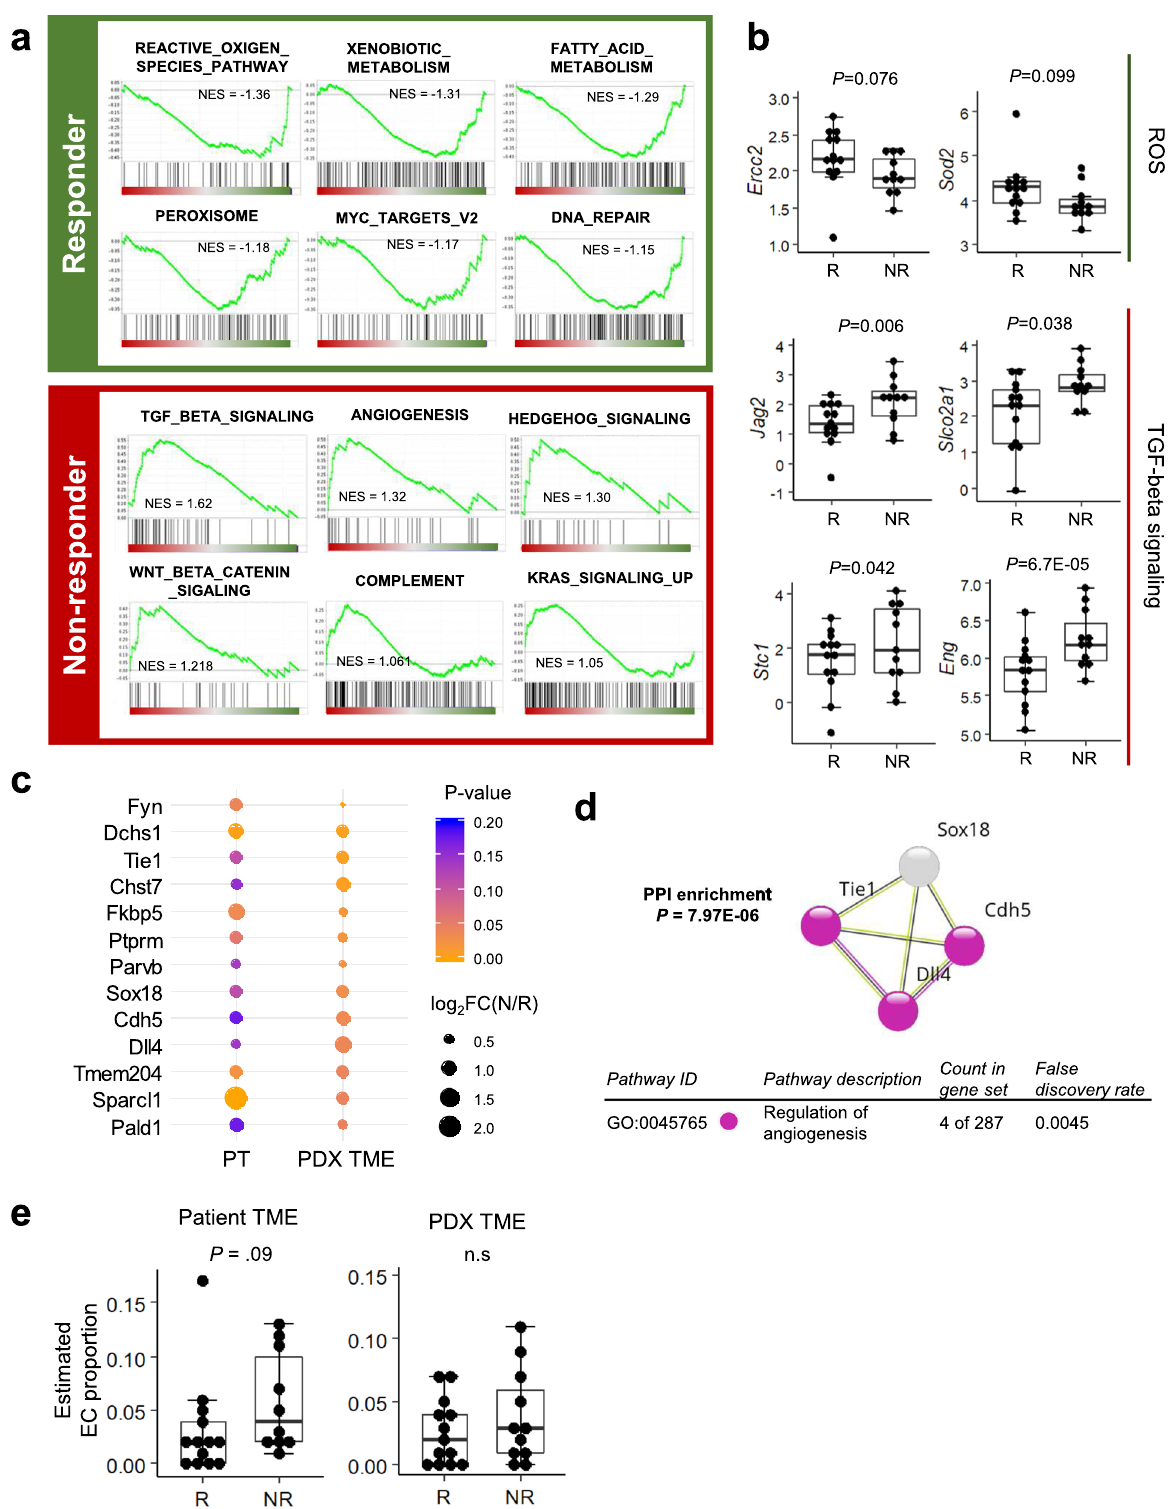
apoptosis, metabolism, ECM interactions, and EMT (Fig. 5a). The predictive model was applied to other independent GC cohorts to con fi rm the predictive value of this model by comparing the estimated responsiveness with patients ’ outcomes. Patients in cohort of ACRG 2 , TCGA 6 and Singapore-Duke study 28 did not receive neoadjuvant therapy and some patients received adjuvant therapy with 5-FU-based regimens. Applied to 300 GC patients of